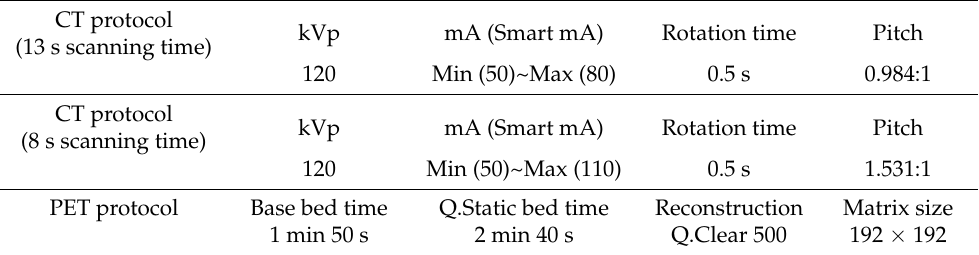
Table 2. 18 F-FDG PET/CT protocol for patient